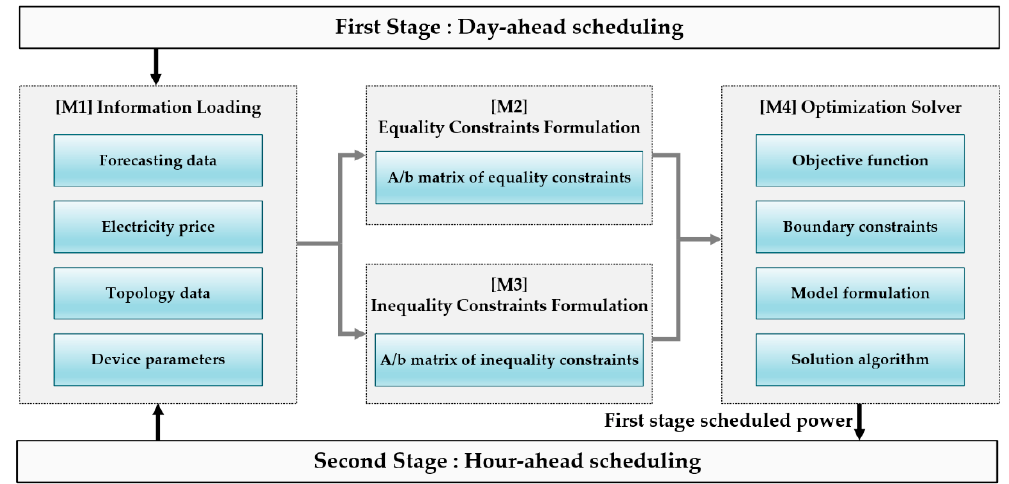
Figure 2. Framework of the two-stage ED modularization architecture.